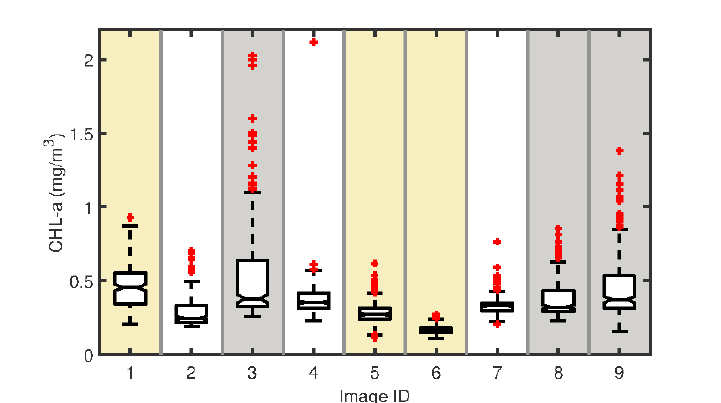
Figure 10. Chlorophyll-a (CHL-a) concentration values presented in the format of box plot associated to each SAR image of our data set. Please note that, for each box plot, the horizontal line inside the box represents the median CHL-a concentration and its first and third quartiles are represented by the lower and upper line of the box. The minimum and maximum CHL-a concentrations excluding outliers are represented by the lower and higher short horizontal bars. The outliers are represented by the red plus signs. The sections with gray background are the ones identified as single-negative signatures of IWs propagating in range direction. The yellow background sections mean that the chlorophyll-a images are not useful owing to cloud coverage.